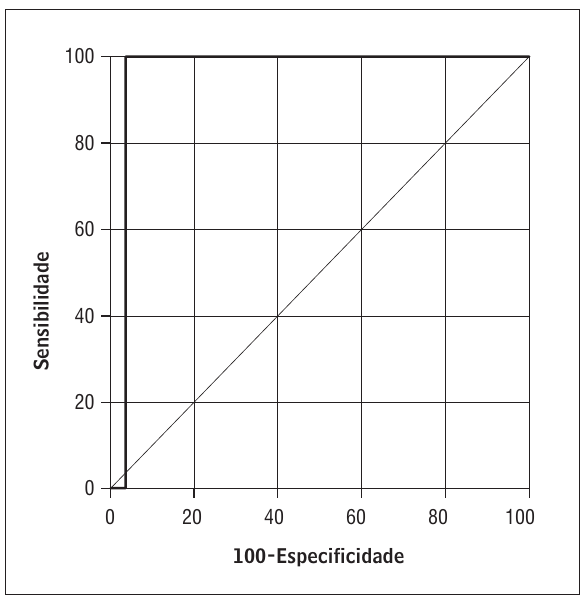
versus PO Fonte: Dados da